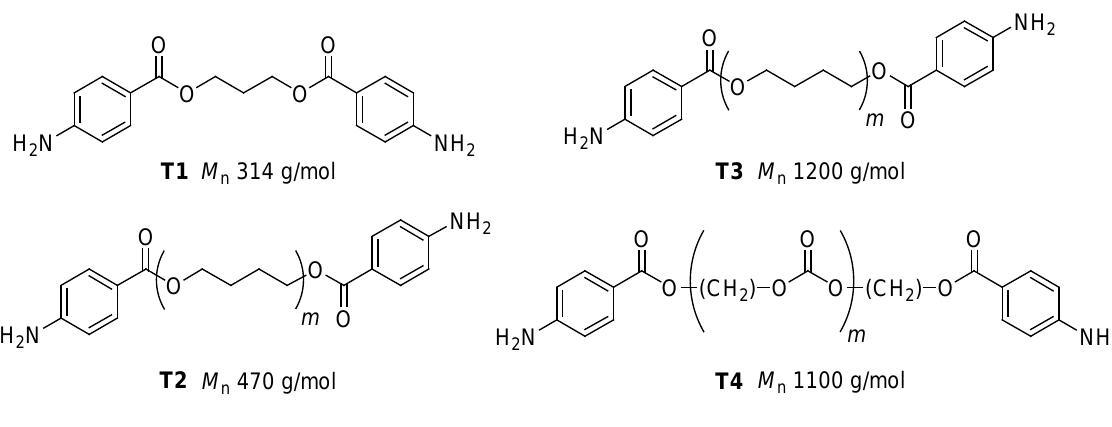
Scheme 3. Schematic representation of a segmented polymer chain (a) without and (b) with the use of a chain extender illustrating the increase in hard segment content as a result of a copolymerization with a short-chain